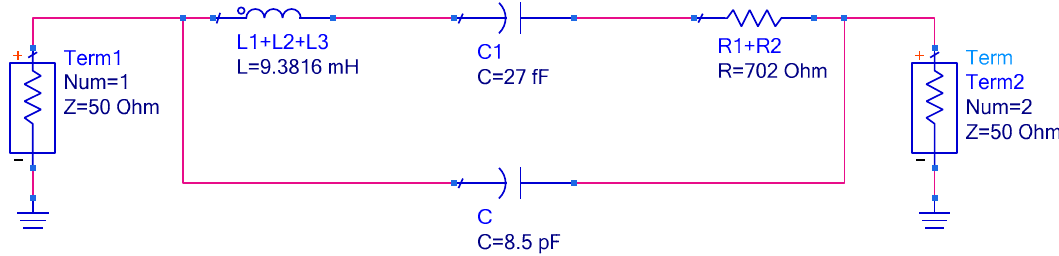
Figure 2. The Butterworth-Van Dyke (BVD) equivalent circuit schematic of Advanced Design System (ADS) simulation.